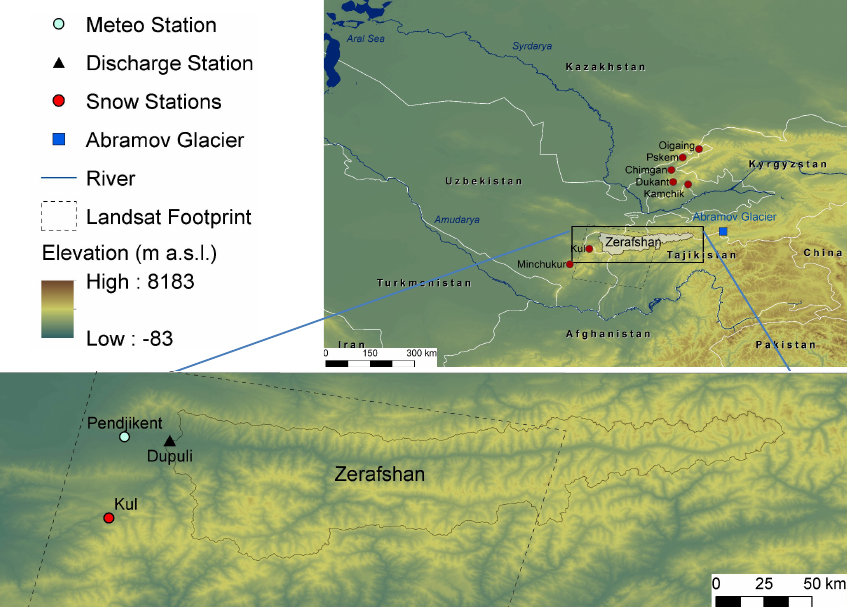
Figure 1. Location of the upper Zerafshan River basin in the Gissaro-Alai mountain range, Central Asia. Snow-cover reconstruction was conducted for the entire area of Fig. 1b and validated for the area with Landsat footprint.